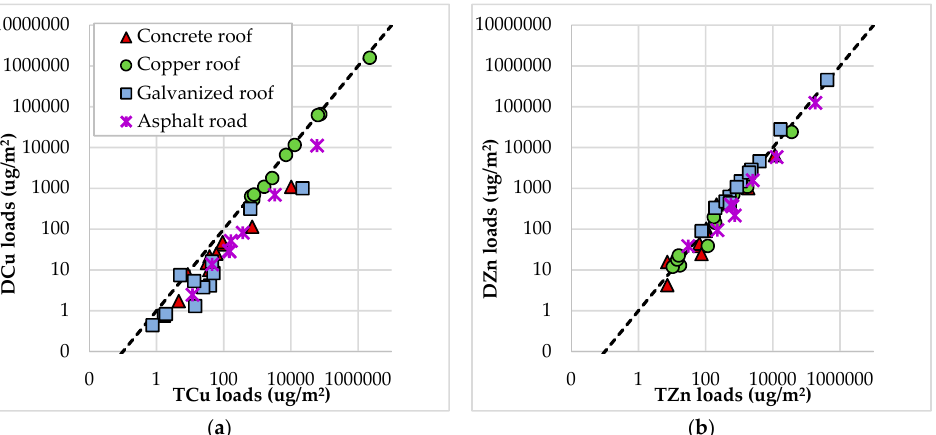
Figure A1. Relationship between observed dissolved loads and observed total loads for ( a ) copper and ( b ) zinc.